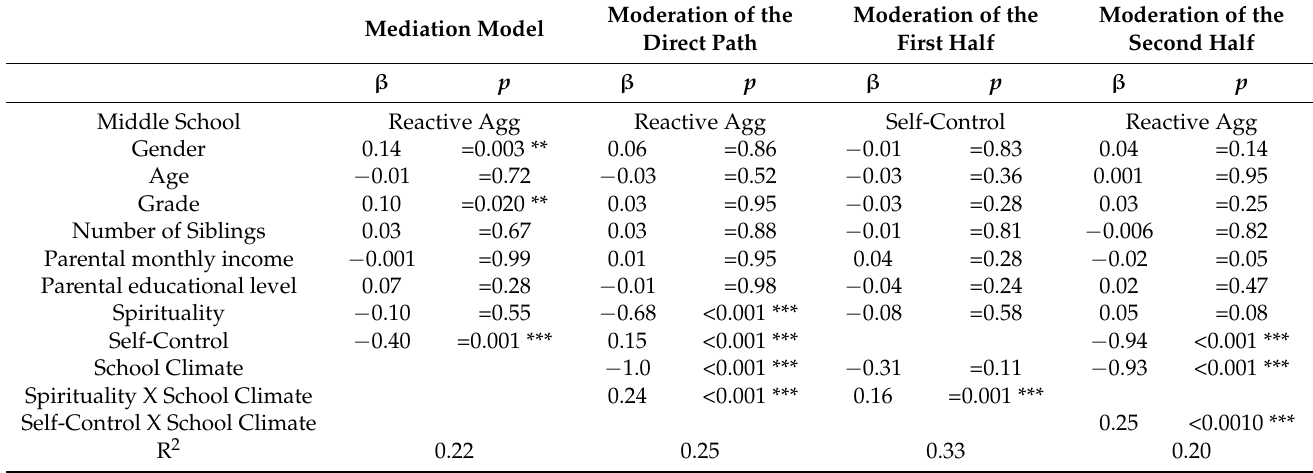
Table 1, Figures 2–4 for the moderating effect. Table 3. Indices of Mediation and Moderation models of the Middle School Sample.